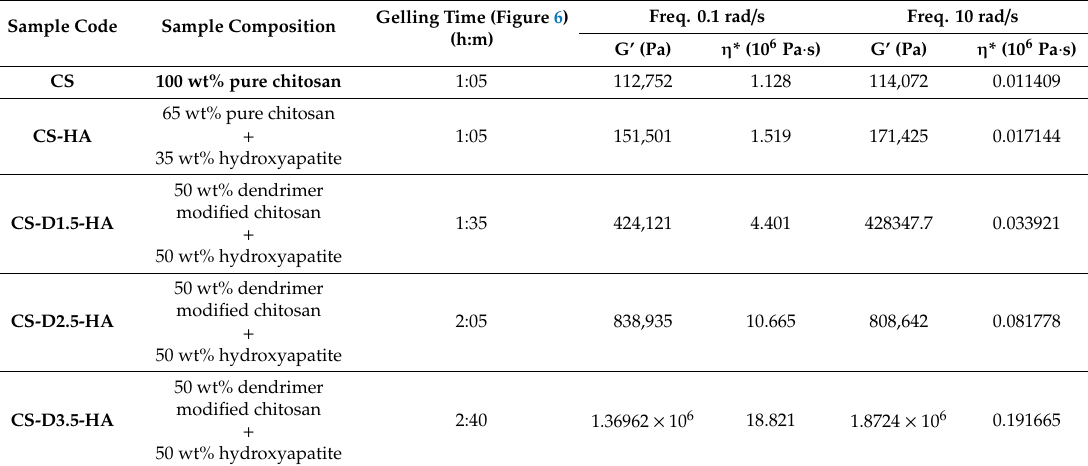
Table 1. Sample code, composition and rheological